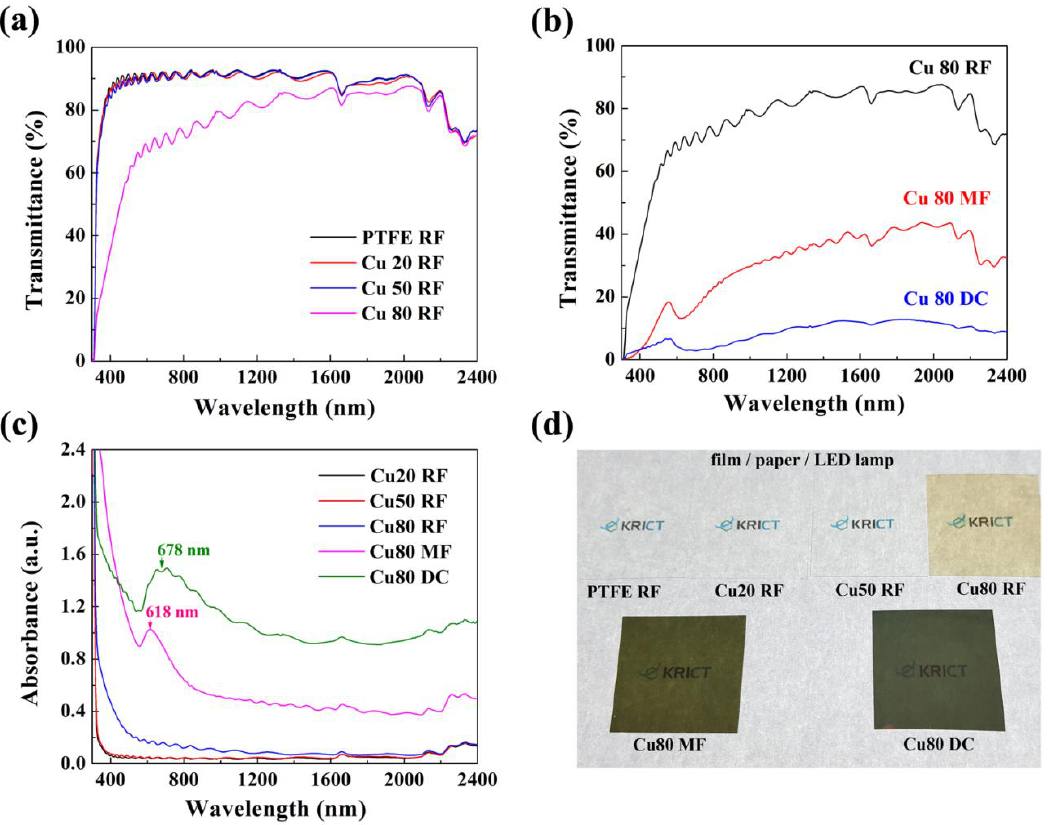
Figure 3. ( a ) Transmittance spectra in the wavelength range 300–2400 nm according to Cu content, ( b ) transmittance spectra according to power sources using the Cu 80 target, ( c ) absorption spectra according to Cu content and power sources, and ( d ) photographs of the Cu/PPFC nanocomposite thin films placed on a LED lamp.